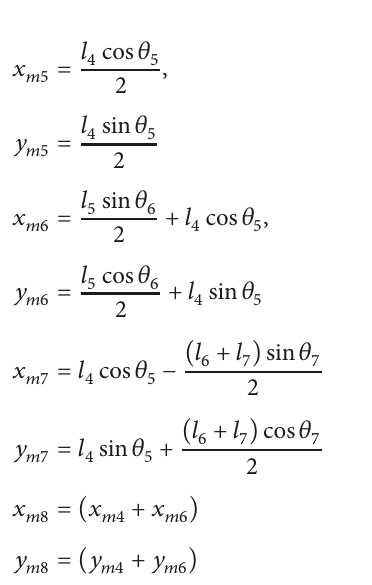
Figure 7: The relation between knee and 𝛽 1